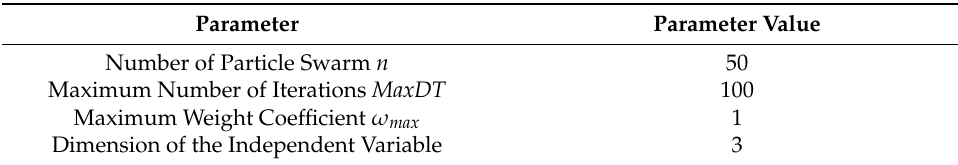
Table 5. The main parameters of